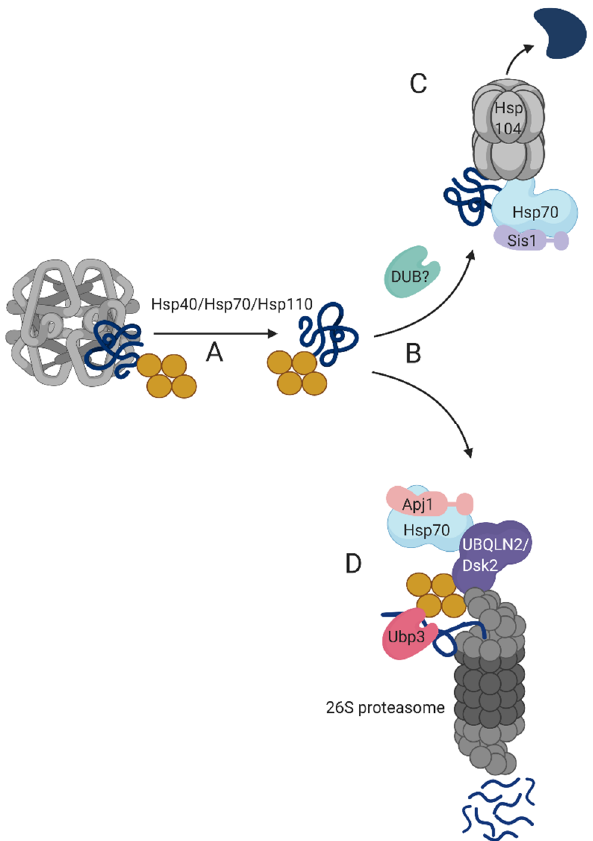
Figure 2. Working model of transient-QC disaggregation. ( A ) Misfolded proteins in transient-QC are dissolved by Hsp40 / Hsp70 / Hsp110 chaperones. ( B ) Once solubilized, misfolded proteins are sorted to either ( C ) refolding or ( D ) degradation. Protein refolding requires the cooperative activity of Hsp40 / Hsp70 bi-chaperones and Hsp104. Protein degradation is facilitated by adaptor proteins, such as UBQLN2 that bridge between the ubiquitylated substrate and the proteasome 19S regulatory subunit. Ubp3 and possibly additional DUBs remove poly-ubiquitin chains from solubilized misfolded proteins prior to proteolysis and refolding. Yellow, ubiquitin conjugates; Dark blue, misfolded substrate.